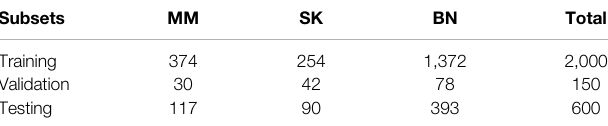
TABLE 1 | Details of ISIC 2017 challenge dataset.